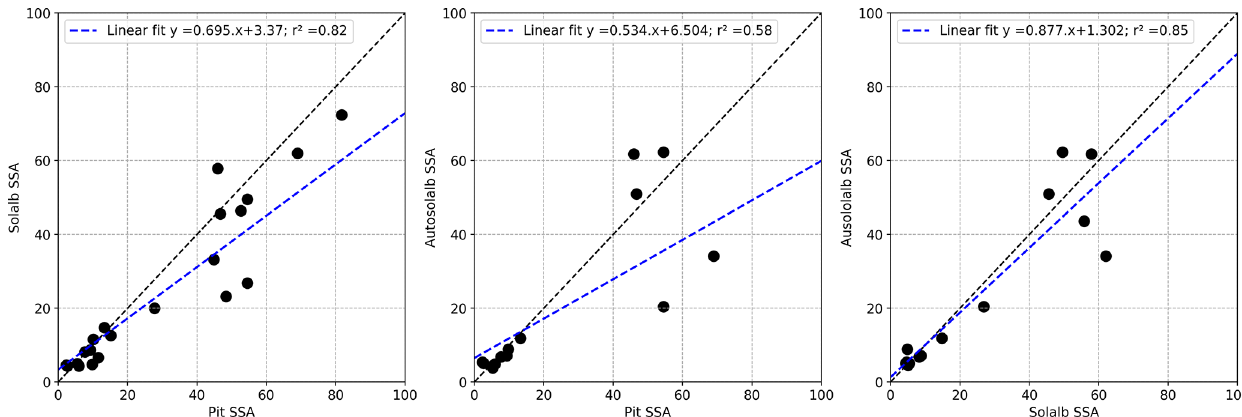
Figure D2. Comparison between the different estimates of near-surface SSA presented in Sect.